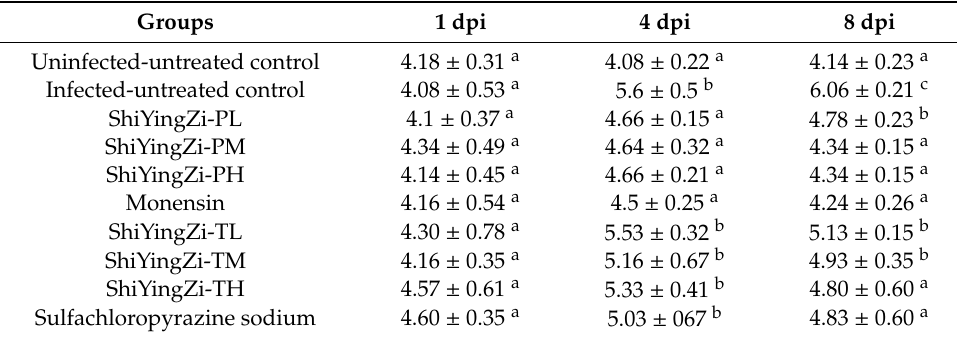
Table 9. The alanine aminotransferase content (U /